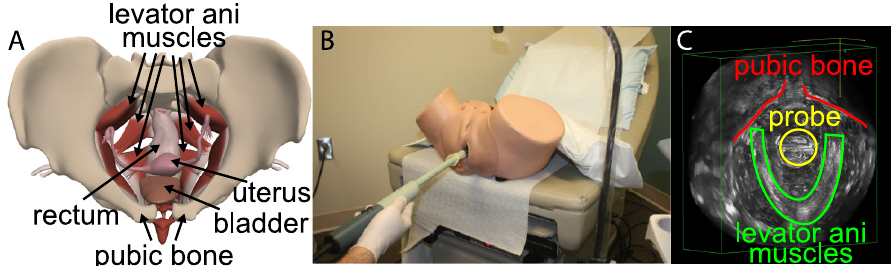
Ultrasound Imaging with 360˚ rotational transducer using a BK Ultrasound System (Flex Focus 500) [9]. (C) Pelvic floor muscle appears as a V-shaped structure in 3DEVUS (green boundary). Pubic bone and probe can also be viewed interactively during acquisition and offline.